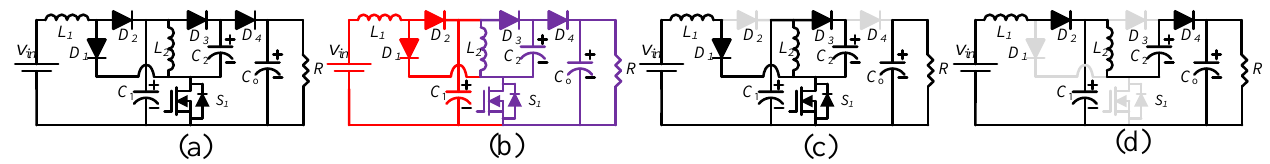
Figure 2. ( a ) The proposed topology, ( b ) how it was made, ( c ) the equivalent circuit of the first mode, and ( d ) the equivalent circuit of the second